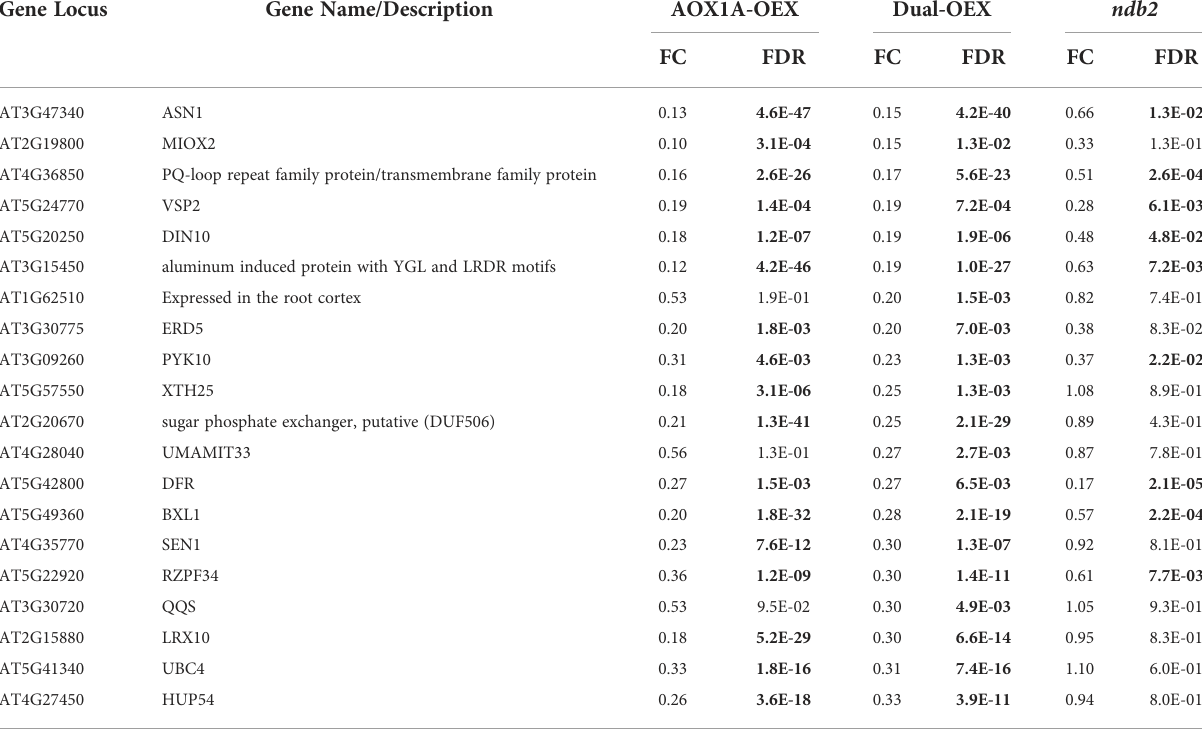
TABLE 6 Top 20 down-regulated DEGs for dual AOX1A and NDB2 overexpression line relative to wild type.